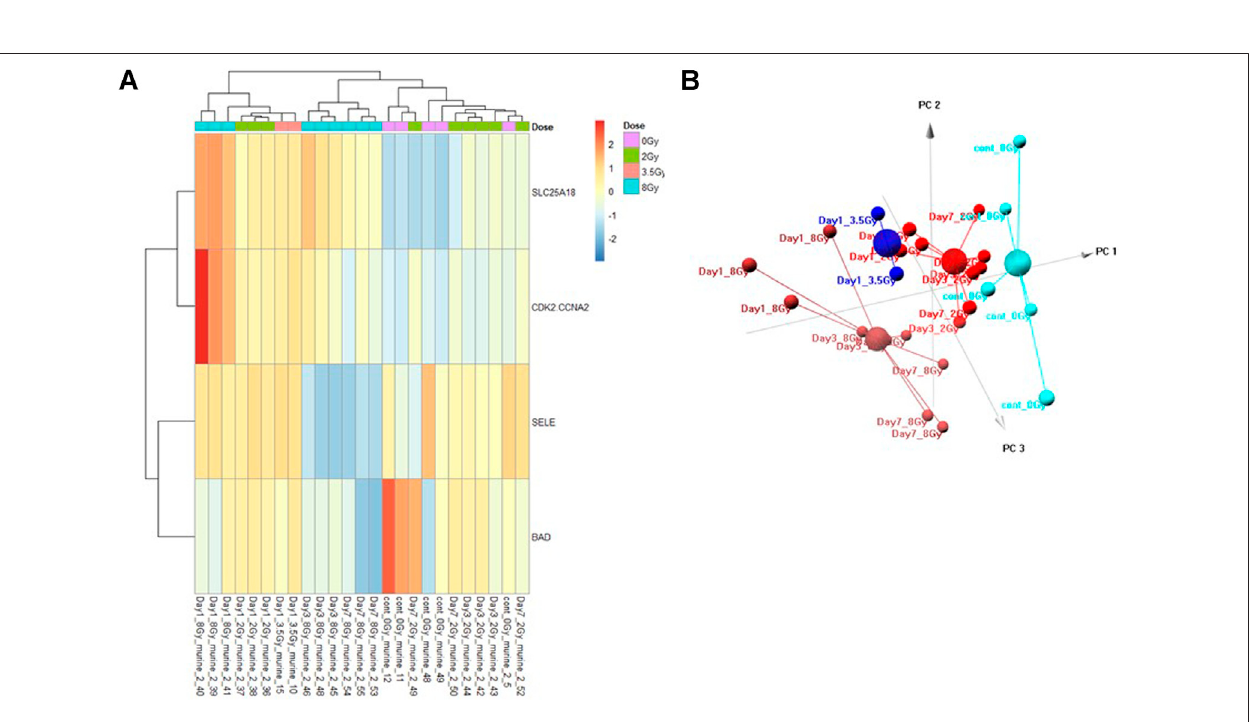
Frontiers in Pharmacology |